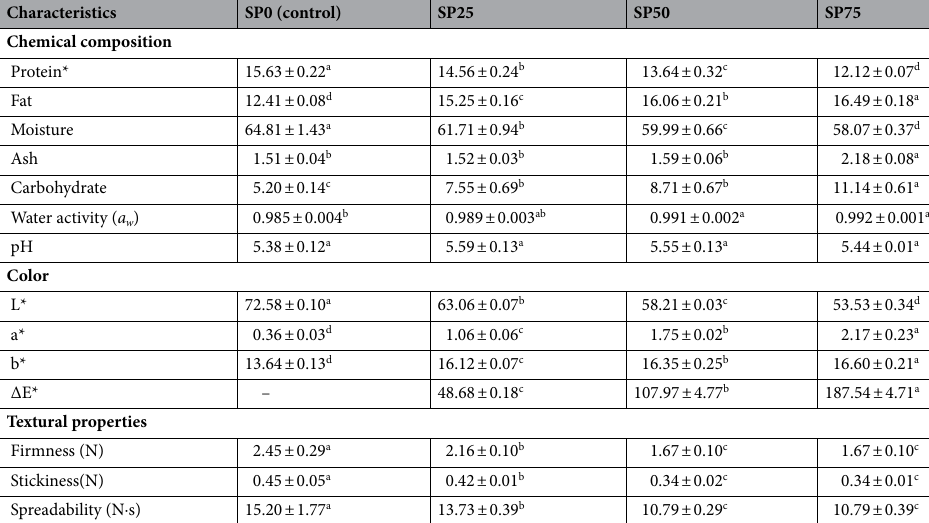
Table 2. Physicochemical characteristics of silkworm pupae-fortified chicken bread spread. Data are expressed as mean ± standard deviation (n = 3; n = 6 for color and textural properties). *The conversion factor used is 6.25. SP0 (Control): Chicken bread spread without silkworm pupae fortification. SP25, SP50, and SP75: Silkworm pupae-fortified chicken bread spread with the replacement of chicken meat at 25, 50, and 75%, respectively. Different lowercase superscripts within the same row indicate significant differences ( p ≤